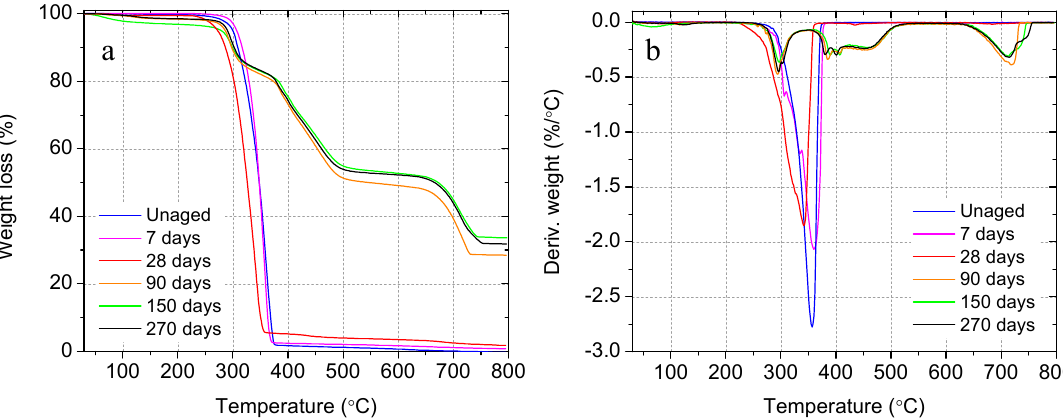
Figure 10. Degradation of PLA capsules in mortar cured in a saturated lime solution at 23 °C: (a) thermogravimetric weight loss, and (b) derivative of weight loss.